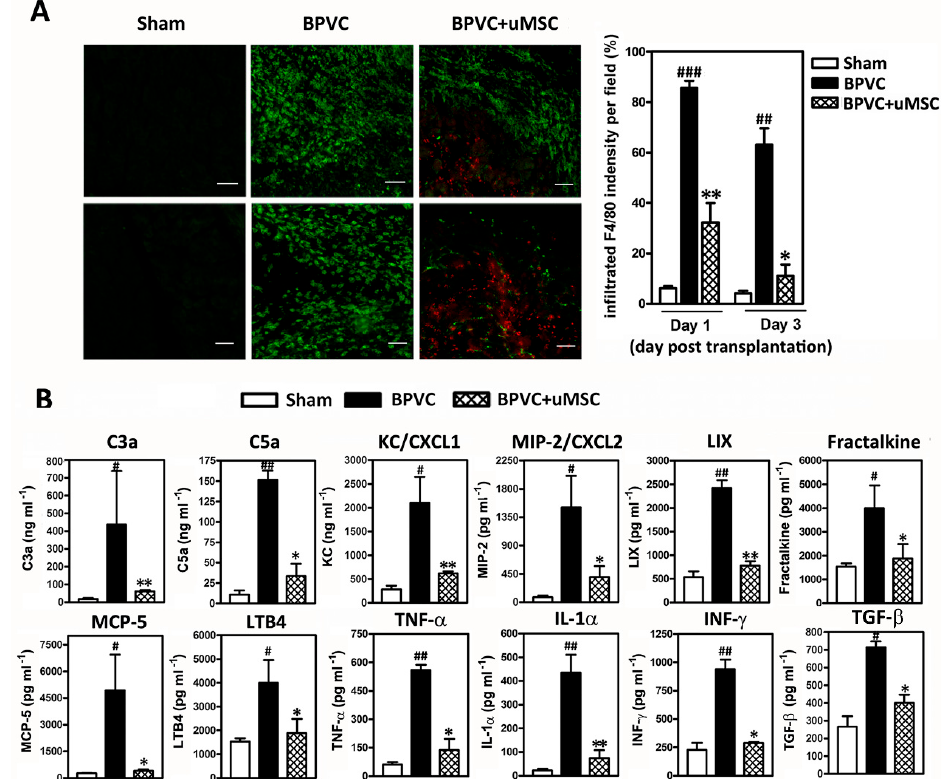
Figure 4. The uMSCs attenuated the BPVC-induced neutrophil infiltration and activation and ameliorated the elevated chemotaxis of cytokines in the early-onset inflammation. ( A ) Representative histological images of tissue sections that show the extent of neutrophil infiltration after BPVC injection. The necrotic regions of the quadriceps muscles two days (upper three panels) or four days (lower three panels) after BPVC injection (middle panel) had elevated neutrophil infiltration (mouse neutrophils were detected by immunolocalization of mouse Lymphocyte antigen 6 complex locus G6D (Ly6G) staining, shown in green fluorescence). The uMSCs were transplanted 24 h after BPVC-injection. Neutrophil infiltration was markedly attenuated following one or three days of uMSC transplantation (right panel; transplanted human uMSCs were localized by immunostaining with a human-specific ribonuclear protein antibody [32,33], presented in red fluorescence). Histograms show the quantification of infiltrated mouse Ly6G per field (percentage ratio) from quadriceps muscles isolated from C57BL / 6 mice which underwent saline-or BPVC injection, or transplantation of uMSCs post BPVC injury. Scale bar: 100 µ m. ( B ) Tissue extracts were collected from quadriceps muscles on day four post saline or BPVC injection, or after three days of uMSC transplantation 24 h following BPVC-injection. The protein levels of chemotaxis for neutrophil activation and recruitment or released cytokines (pro-inflammation or pro-fibrosis) associated with each group of mice were determined using the Quantibody Mouse Cytokine Array ( n = 6 / group). Data are given as means ± SD; # p < 0.05, ## p < 0.01, ### p < 0.001 for BPVC group vs. sham group; * p < 0.05, ** p < 0.01 for BPVC + uMSC group vs. BPVC